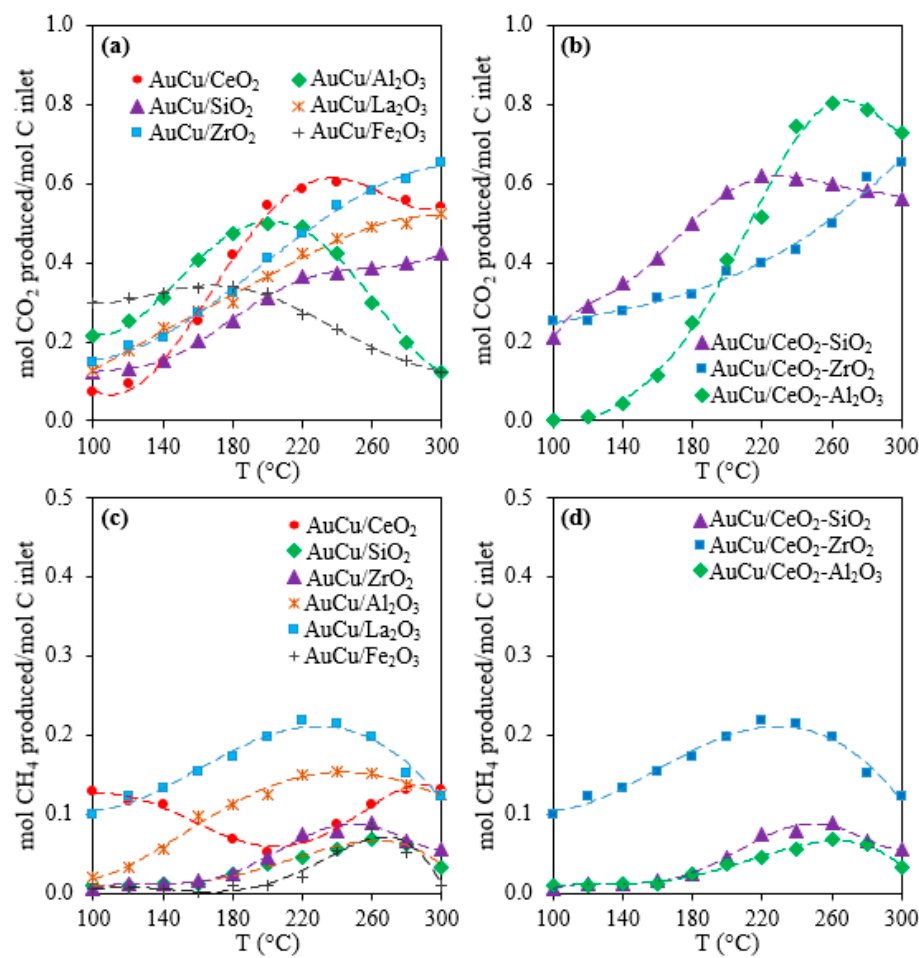
Figure A2. ( a , b ) CO 2 and CH 4 ( c , d ) production in the CO cleanup reactor with Au–Cu catalysts supported on simple and dual supports. Syngas composition: 8.4% H 2 , 2.2% CO, 0.6% CO 2 , 0.3% CH 4 , 1.6% H 2 O, and Ar. λ =1.8. Reaction conditions: SV = 6.5 ± 0.2 L/g cat *min; 0.050 g of catalyst and 0.250 g of inert quartz. Catalysts 2019 , 9 , x FOR PEER REVIEW 20 of 27